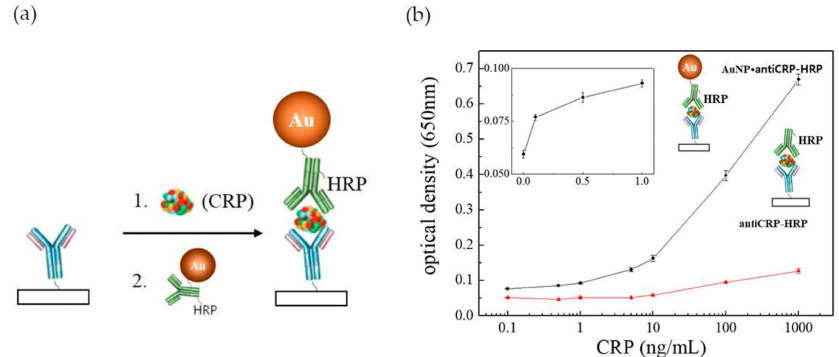
Figure 11. ( a ) Schematic illustration of the use of Au NPs conjugated with HRP-labelled anti-CRP on “capillary ELISA”. Reproduced with permission from ref. [54]. Copyright Elsevier, 2016; ( b ) Representation of optical density against CRP concentrations plot in Au NP “capillary ELISA” (black line) and common ELISA (red line). The inset represents the linear plot of lower CRP concentrations range in Au NP “capillary ELISA”. Reproduced with permission from ref. [83]. Copyright MDPI,